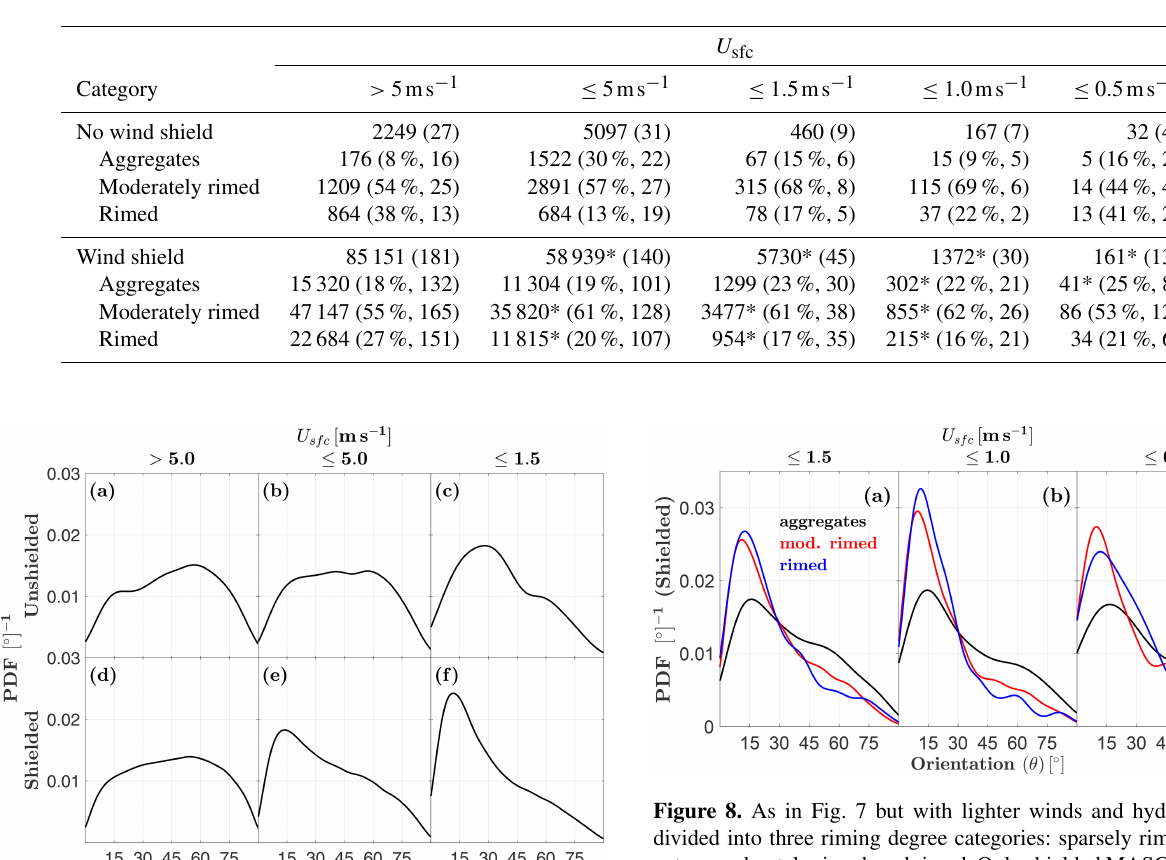
Table 1. Number and percentage of observed hydrometeors in each wind shielding case, surface wind speed U sfc category, and riming class. Whole numbers in parentheses indicate the number of distinct events for each category. For each wind-shielded riming category, * indicates where the difference in the complexity ( χ ) distribution for each low-wind case is statistically significant at the 5% level from that of the respective high-wind case ( U sfc > 5ms − 1 ). Percentages may not add to precisely 100% due to rounding. Less restrictive wind speed